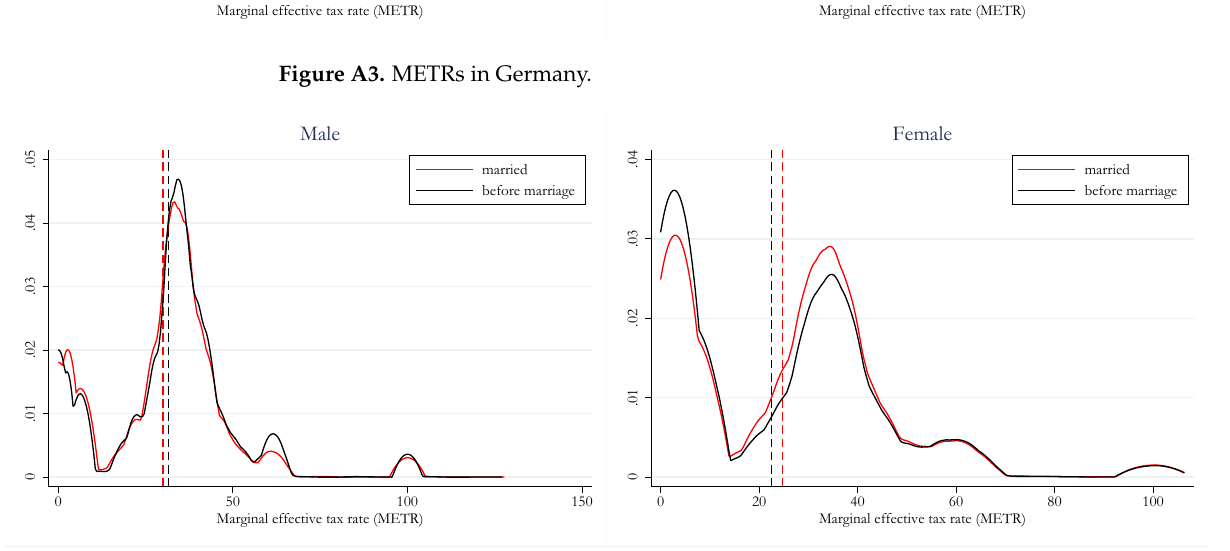
Figure A3. METRs in Germany.